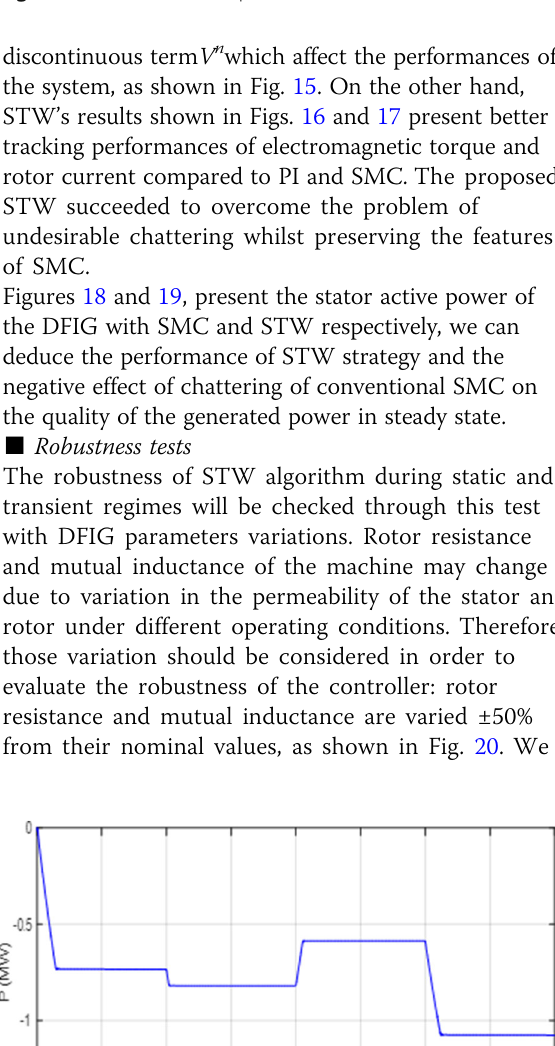
Fig. 18 DFIG stator active power with SMC